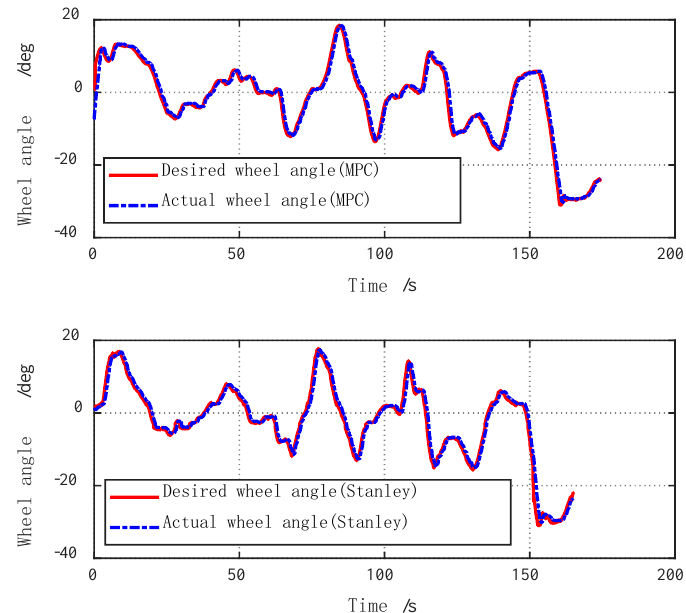
Figure 17. Vehicle wheel angle of MPC control and Stanley control.